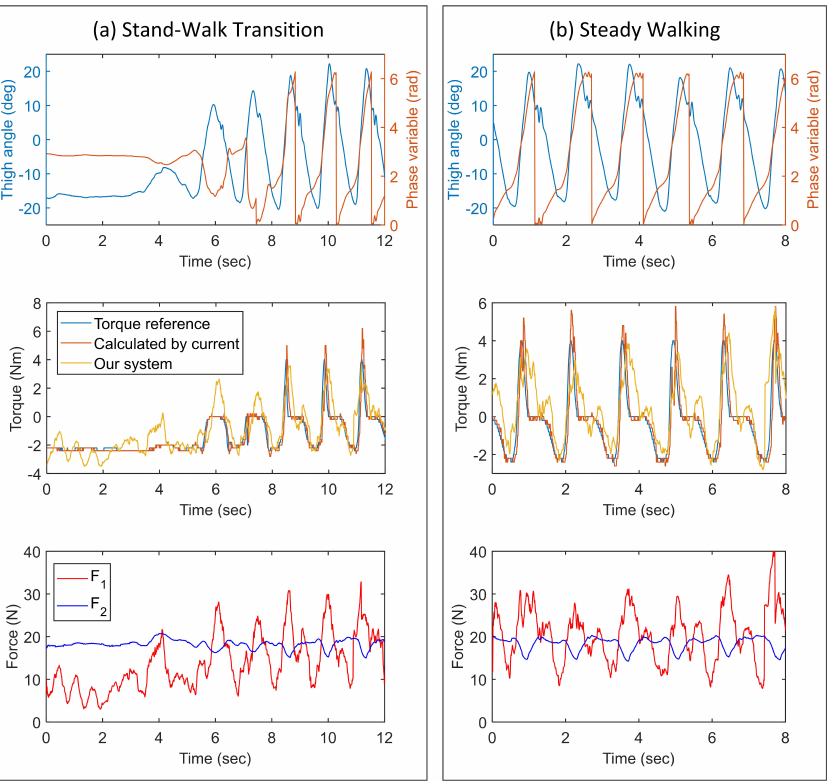
Figure 14. Torque measurements of hip exoskeleton experiments ( µ 1 = 0.45, µ 2 = 0.65, σ 1 = 15, σ 2 =